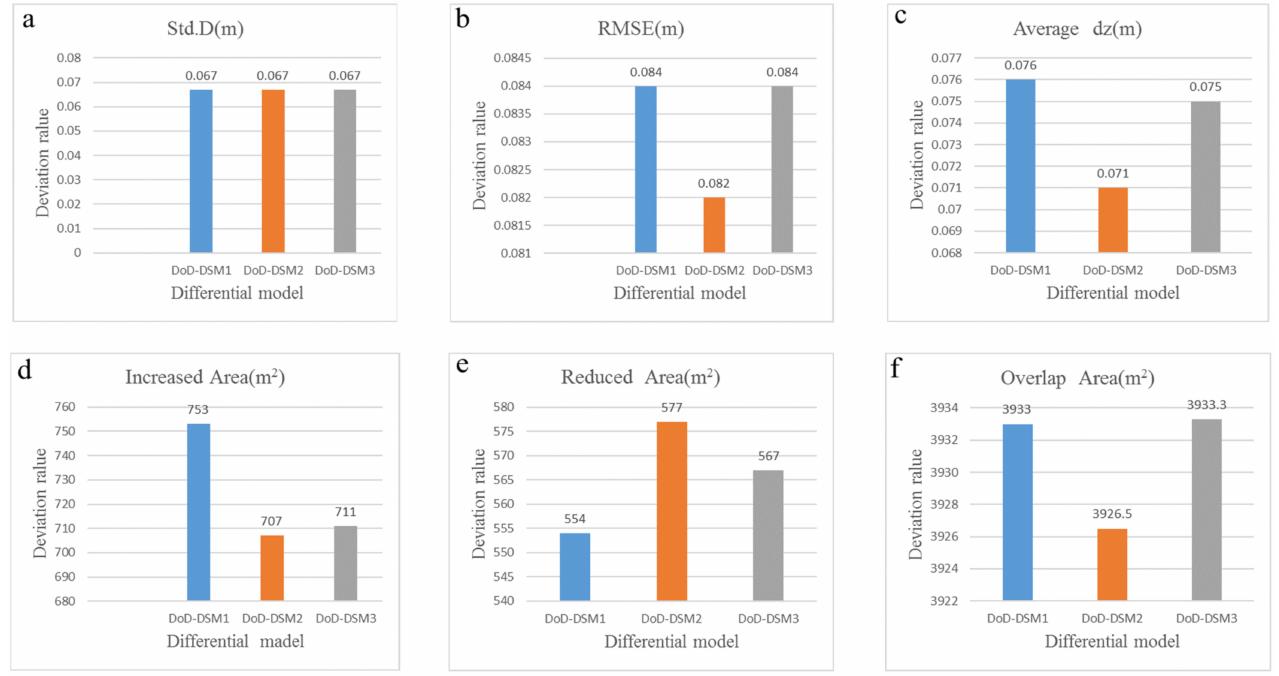
Figure 6. Statistical graph of the degree of deviation of each evaluation index in DOD-DSM model ( a ) Std.D value statistics; ( b ) RMSE value statistics; ( c ) Average value statistics; ( d ) Increased area value statistics; ( e ) Reduced area value statistics; ( f ) Overlap area value